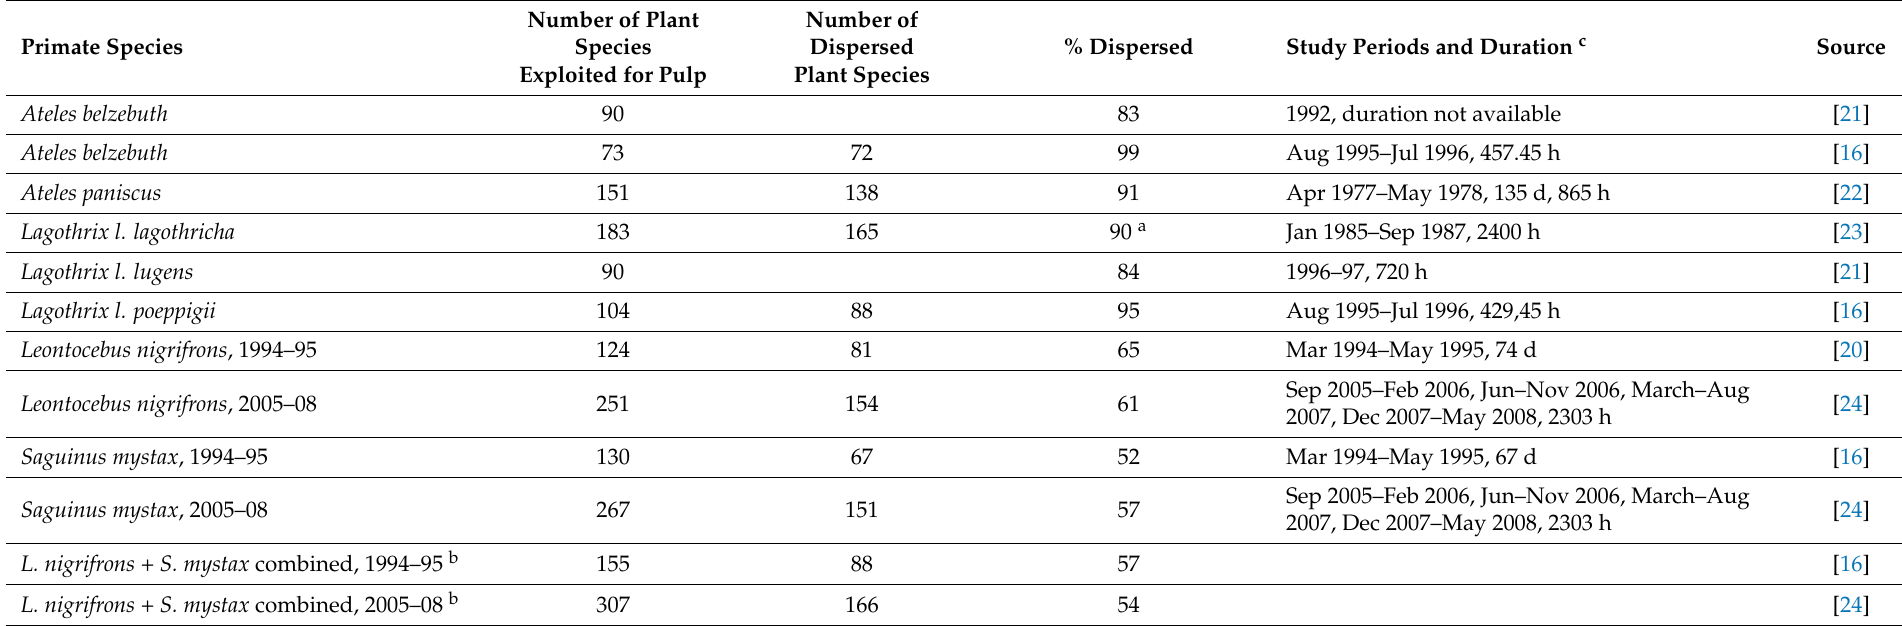
Table 1. Number of plant species exploited for fruit pulp, and number and percentage of plant species whose seeds are dispersed. Number of Plant Primate Species Species Exploited for Pulp Plant